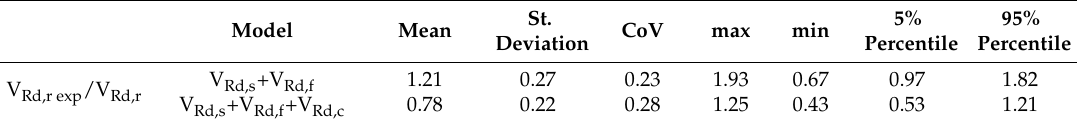
Table 6. Statistical values of the predictions: mean, Standard deviation, Coefficient of Variation,